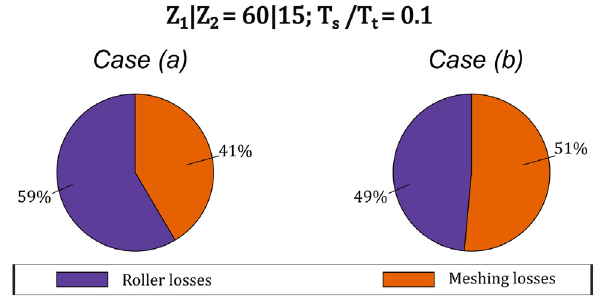
Fig. 22. Comparison between case (a) and